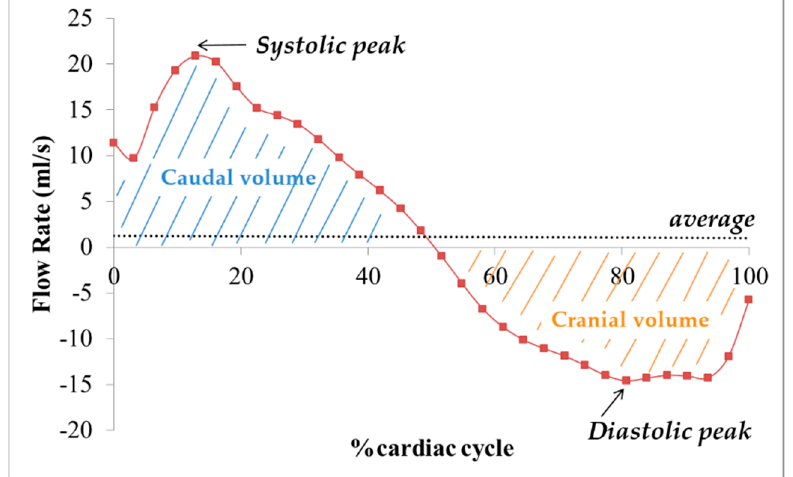
Figure 3. Aqueduct of Sylvius (AoS) cerebrospinal fluid (CSF) flow rate and volume. The flow rate